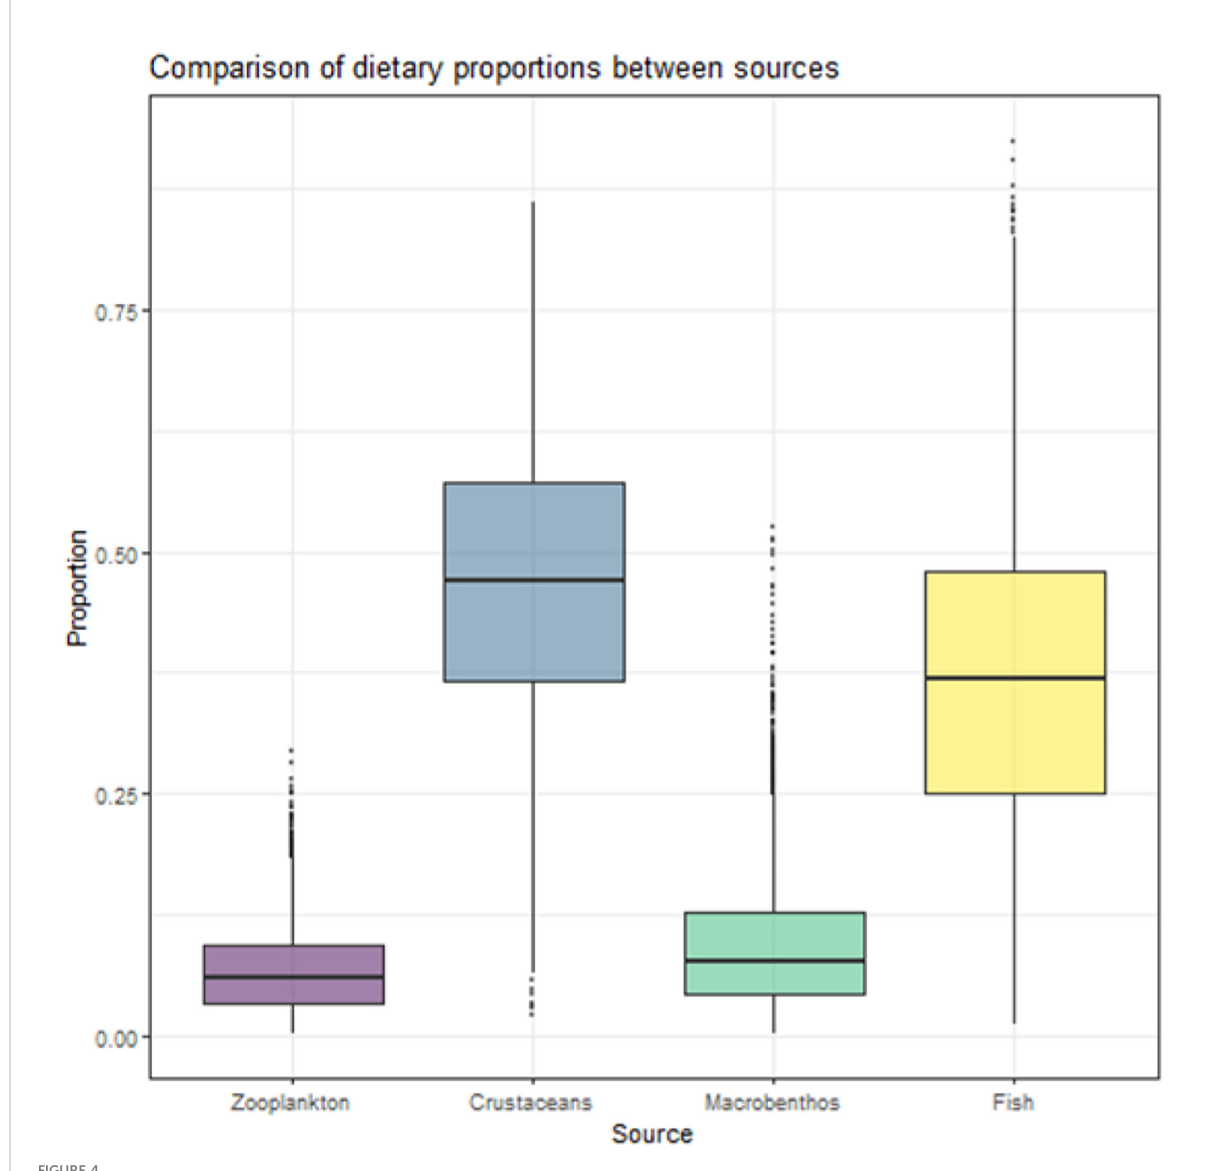
FIGURE 4 Composition of different food resources of M.